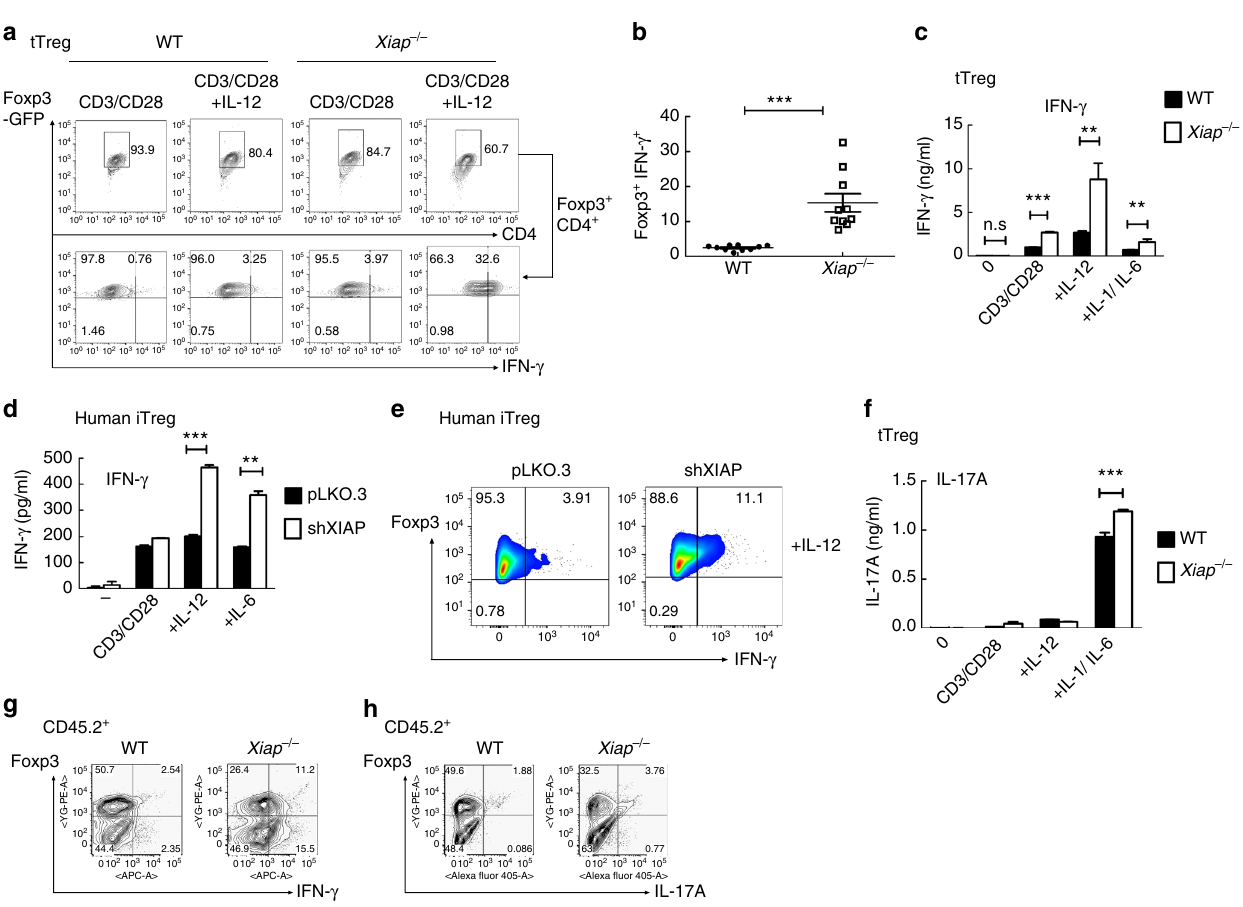
Fig. 5 Enhanced conversion of XIAP-de fi cient Treg cells into Foxp3 + IFN- γ + cells. a , b Increased transition of Xiap − / − tTreg cells into IFN- γ -producing cells. WT and Xiap − / − tTreg cells (Foxp3-GFP tagged) were isolated by GFP-expression and re-stimulated with plate-bound anti-CD3/CD28 and IL-2 (CD3/ CD28), with additional IL-12 ( + IL-12, 50 ng ml − 1 ), for 4 days. tTreg cells were then reactivated with TPA/A23187 for 6 h, and the expressions of IFN- γ in the gated GFP + (representing Foxp3 + ) fraction were determined by intracellular staining ( a ). Quantitation of Foxp3 + IFN- γ + cells from tTreg cells isolated by either Foxp3-GFP or CD4 + CD25 + expression ( b ), n = 10. *** P < 0.001 for unpaired t -test. c Increased secretion of IFN- γ by Xiap − / − tTreg cells. Puri fi ed WT and Xiap − / − tTreg cells were stimulated as in ( a ), or with additional IL-6 plus IL-1 α + IL-1 β ( + IL-6/IL-1), and re-activated with TPA/A23187 for 24 h and the levels of IFN- γ in supernatants was analyzed by ELISA. d , e Enhanced expression and secretion of IFN- γ by human XIAP-knockdown iTreg cells. Human control and XIAP-knockdown iTreg cells were activated by anti-CD3/CD28 and IL-2, with the addition of IL-12 or IL-6, as indicated, for 4 days. Secretion of IFN- γ was quantitated ( d ) and intracellular expressions of Foxp3 and IFN- γ were determined ( e ). f Elevated secretion of IL-17A by Xiap − / − tTreg cells. WT and Xiap − / − tTreg cells were stimulated as in ( c ) and the generated IL-17 was quantitated by ELISA. g , h Increased expression of IFN- γ and IL-17 in the adoptively transferred Xiap − / − tTreg cells. WT or Xiap − / − CD45.2 + tTreg cells were administrated into Rag1 − / − CD45.1 + mice together with WT CD45.1 + CD4 + CD25 − effector T cells. Mice were killed after 27 days and CD4 + T cells from spleen and lymph nodes were isolated. CD4 + T cells were activated by TPA/A23187 and the expressions of Foxp3, IFN- γ ( g ) and IL-17A ( h ) in CD45.2 + cells were determined by intracellular staining. Values ( c , e , f ) are mean ± SD of triplicate samples in an experiment. * P < 0.05, ** P < 0.01, *** P < 0.001 for unpaired t-test. All experiments ( a – h ) were independently repeated